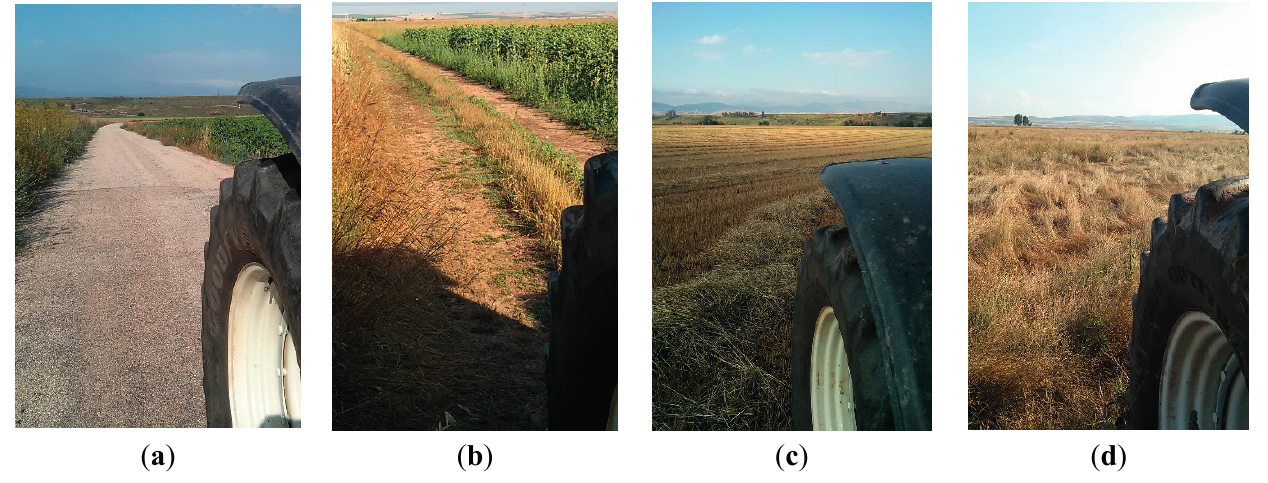
Figure 5. Test surfaces: ( a ) paved road; ( b ) unpaved road; ( c ) cultivated plot; and ( d ) uncultivated